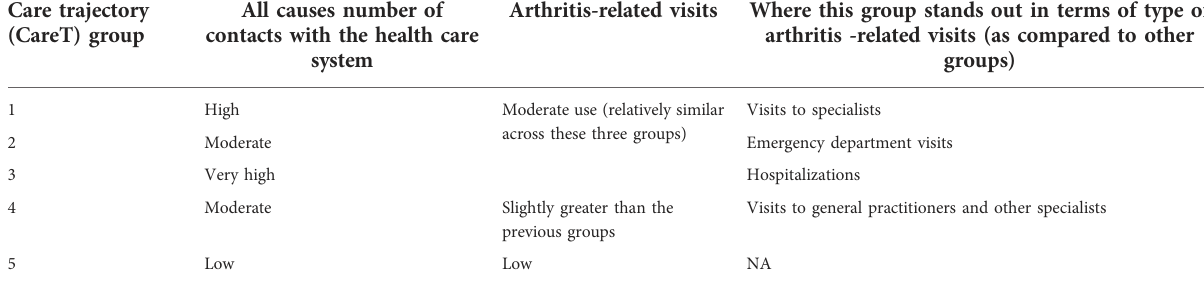
TABLE 2 CareT groups ’ description.